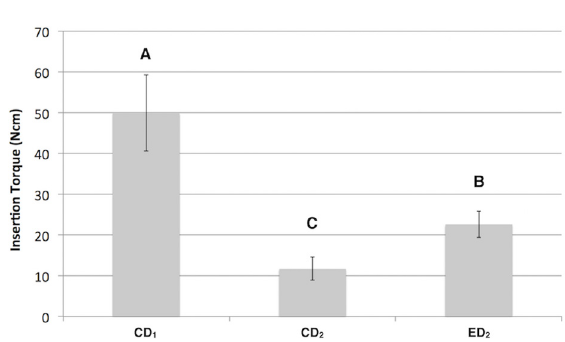
Figure 1 - Mean insertion torque values (Ncm) for different experimental groups: control technique and higher bone density (CD ); control technique and lower bone density (CD 1 undersized drilling technique and lower bone density (ED Different capital letters above the bars represent significant statistical difference between the groups